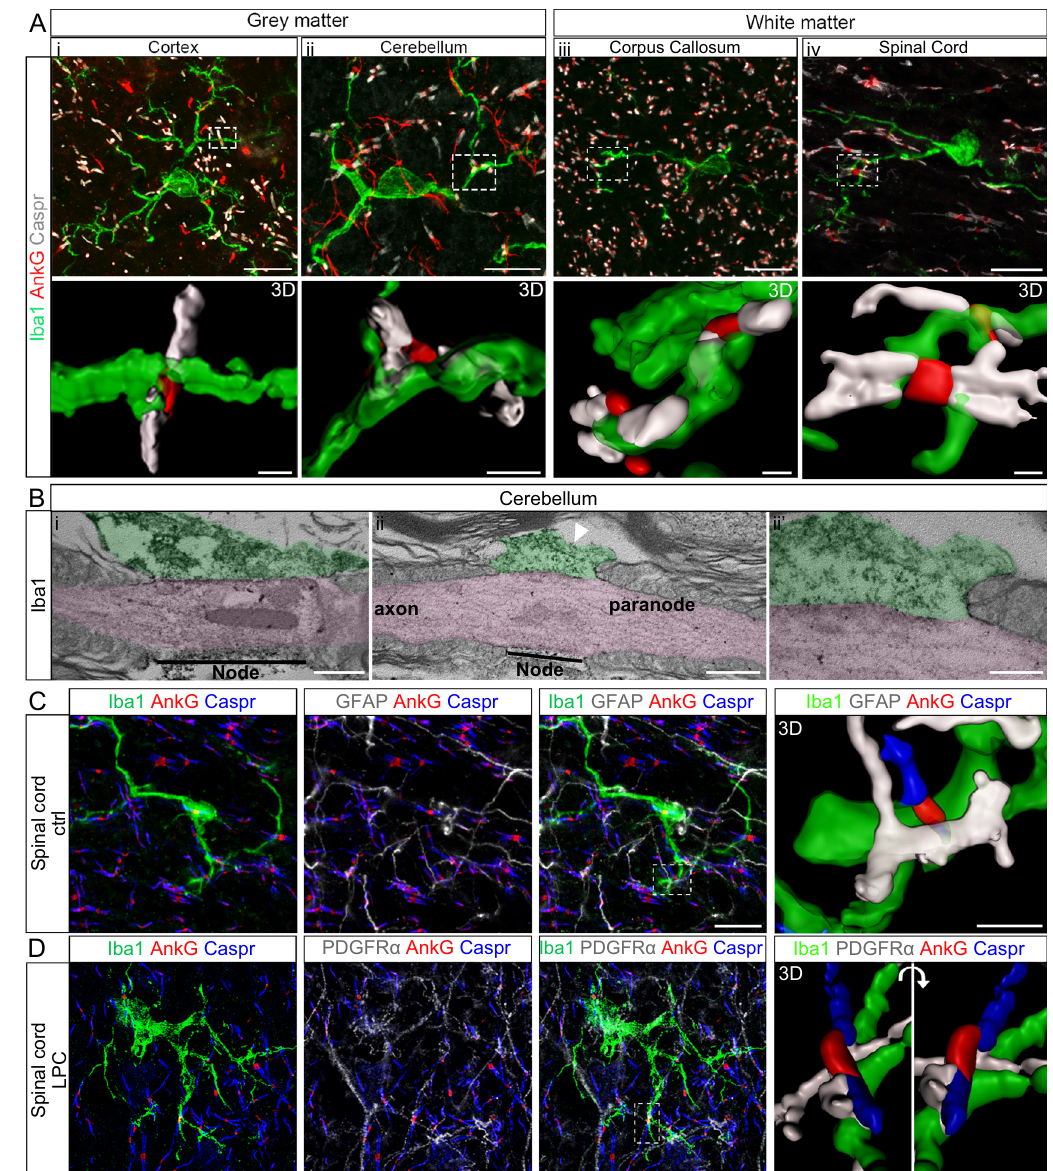
Fig. 1 Microglial cells contact nodes of Ranvier in mouse central nervous system. A In adult mouse nervous tissue, microglial cells (Iba1, green) contact nodes of Ranvier (AnkyrinG, indicated as AnkG in the fi gures, red) in grey (i, cortex and ii, cerebellum) and white matter (iii, corpus callosum and iv, dorsal spinal cord, cortico-spinal tractus). A i – iv 3D reconstruction of boxed area in i to iv respectively. B i – ii ′ Transmission electron micrographs showing microglial processes (Iba1 + , green) contacting directly the nodal axolemma (pink) in adult mouse cerebellum. ii ′ Higher magni fi cation of the micrograph (ii), showing the interaction between the microglial process, the axolemma and fi rst paranodal loop. C , D Immuno fl uorescent stainings of adult mouse dorsal spinal cord showing nodes of Ranvier (AnkyrinG, red) contacted by both a microglial cell (Iba1, green) and an astrocyte (GFAP, white) in control condition (ctrl) ( C ) and a microglial cell (Iba1, green) and an oligodendrocyte progenitor cell (PDGFR α , white) in remyelinating condition (LPC) ( D ). 3D reconstructions correspond to the boxed area. Scale bars: A , C , D 2D: 10 μ m; 3D: A 1 μ m, C , D 2 μ m; B i – ii 500 nm, B iii 200 nm. A , C , D : n = 4 animals, B : n = 3